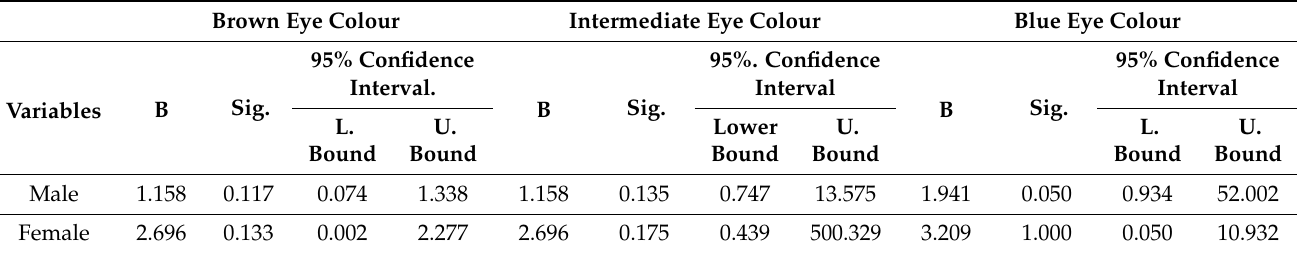
Figure 2. Percentage of eye colour based on gender . Table 1. Multinomial logistic regression analysis between gender and eye colour. The bold value indicated the significance with eye colour.